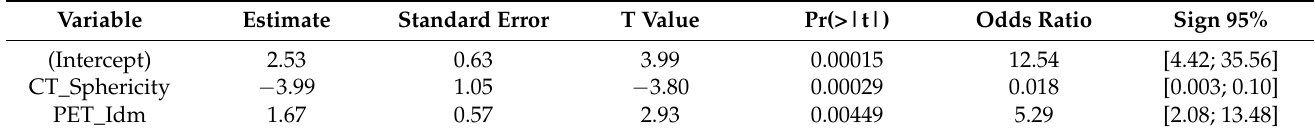
Table 3. GLM regression model for radiomic feature in predicting the presence of liver metastases.